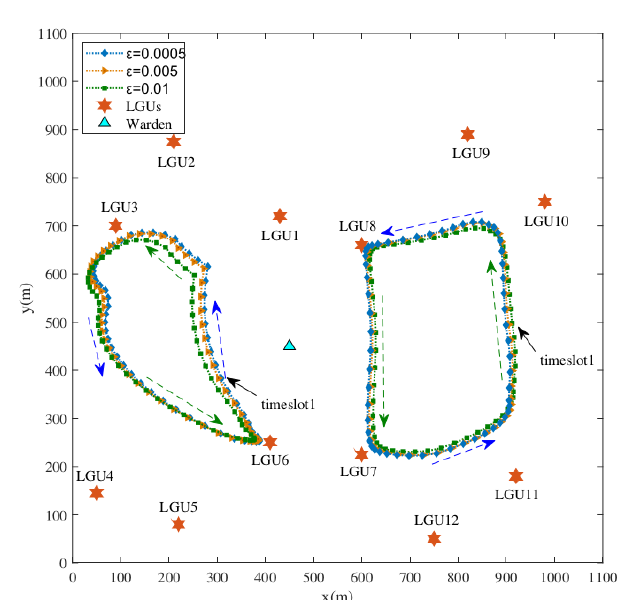
Figure 4. Optimized multi-UAV trajectory for different coverage